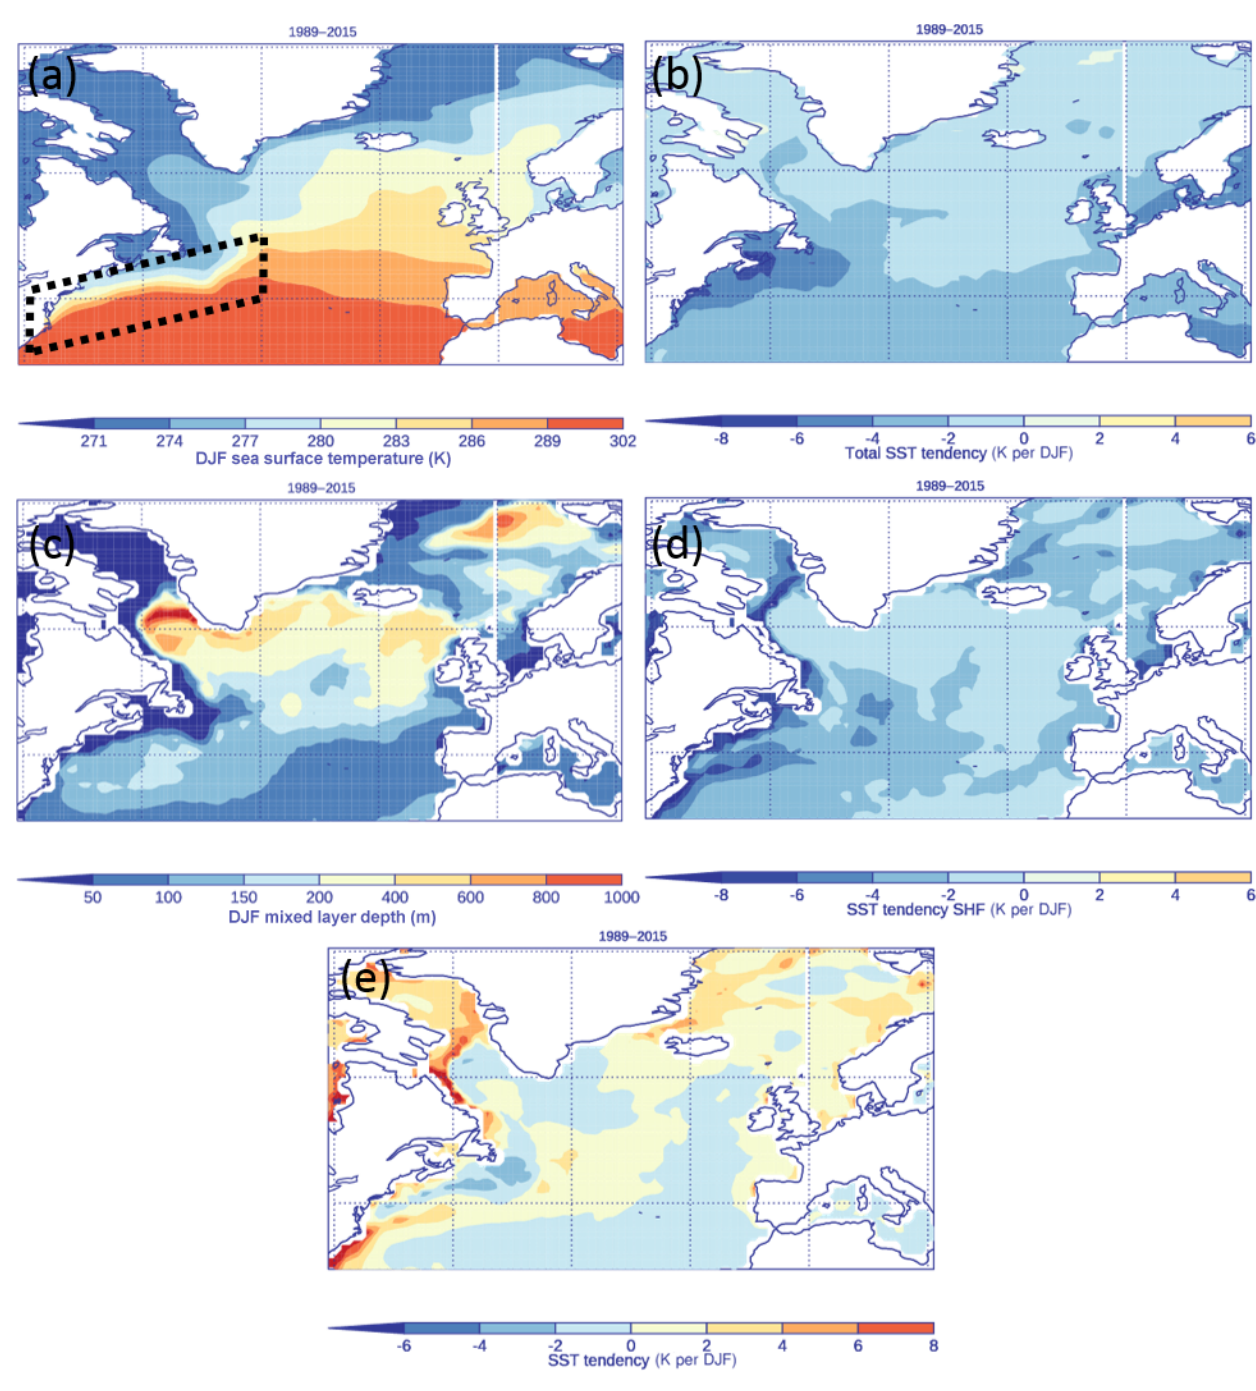
Figure 4. North Atlantic DJF 1989–2015 (a) sea surface temperature (SST; K), black dotted box outlines region of the Gulf Stream, (b) (cid:49) SST TOT (K per DJF), (c) mixed layer depth (m), (d) (cid:49) SST Q